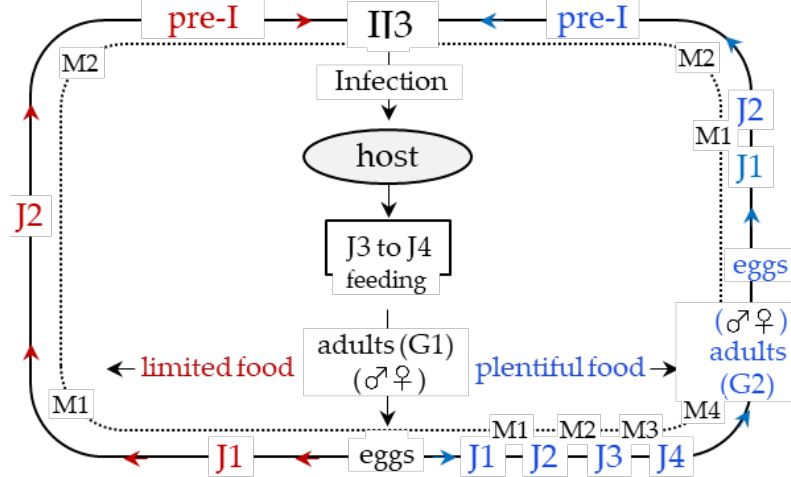
Figure 2. EPNs life cycle. After infection of the host, the infective juvenile stage (IJ3) develop to J4 and to adults (G1), and after mating the eggs develop to J1. If food is scarce, they molt in succession to J2 and pre-I (pre-infective stage juvenile), which will become infective (IJ3). Otherwise, in the presence of abundant food, nematodes molt in succession to the fourth stage (J4), and to adults (G2), and after mating eggs develop into J1, J2, pre-I and finally to IJ3. At the IJ3 stage nematodes search for new